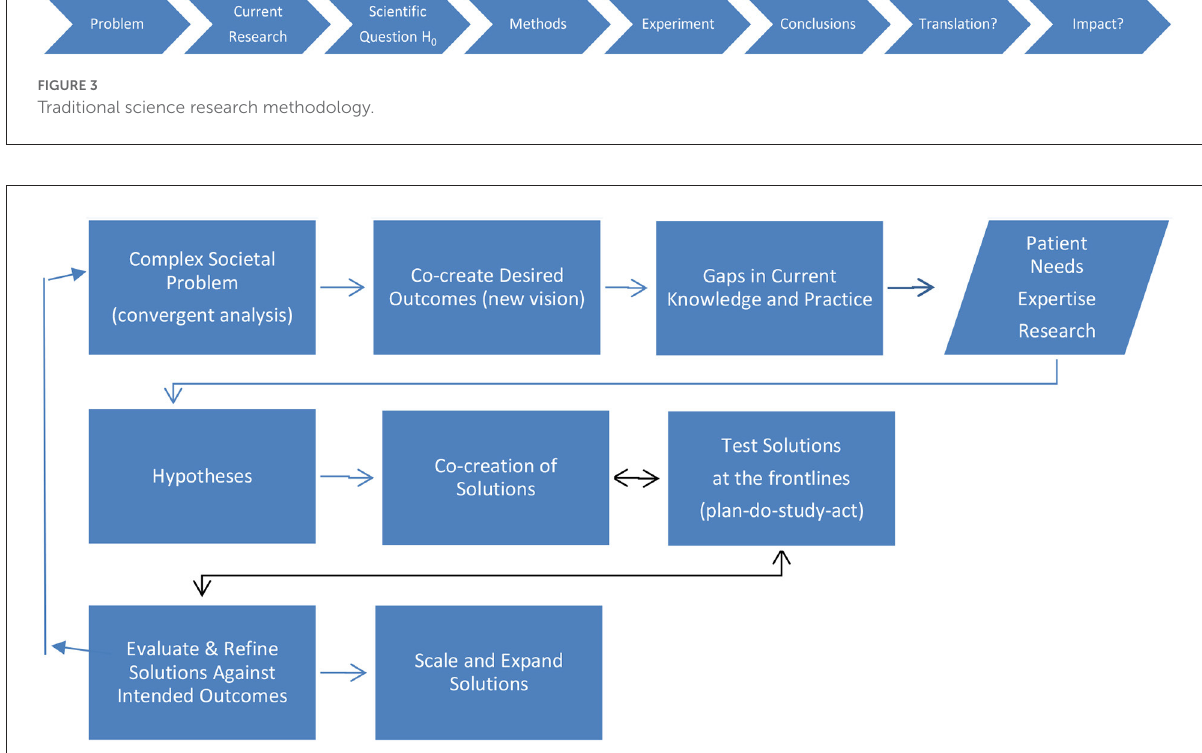
FIGURE4 Transdisciplinary, convergent transformation research.